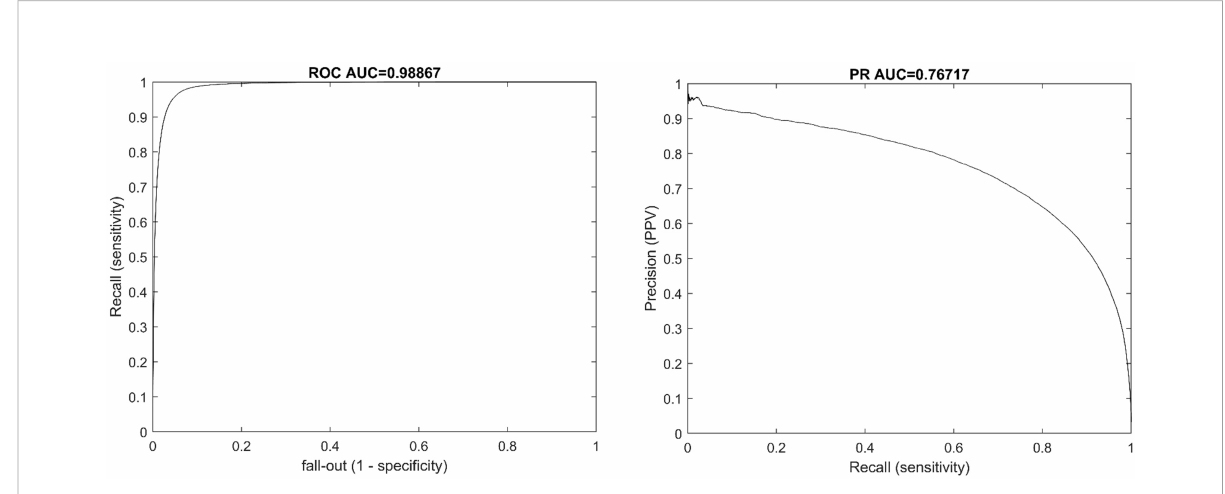
FIGURE 1 ROC and PR curves of the sample-based performance from the test dataset (real